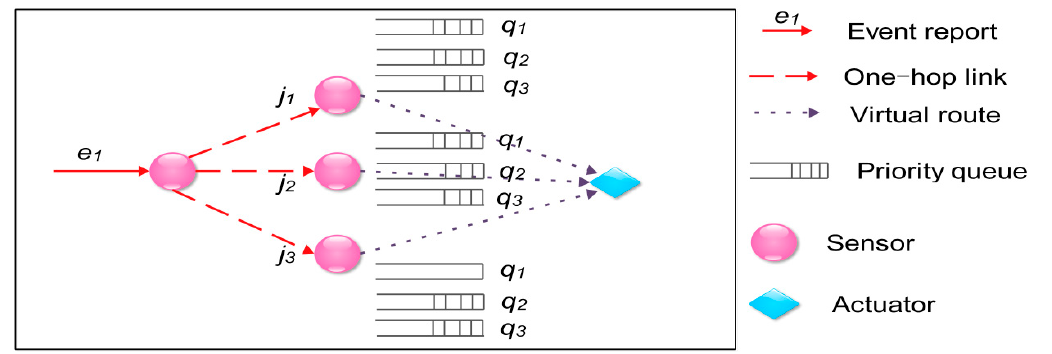
Figure 3. Route selection utilizing the priority queue model (priority: q 1 > q 2 > q 3 ).